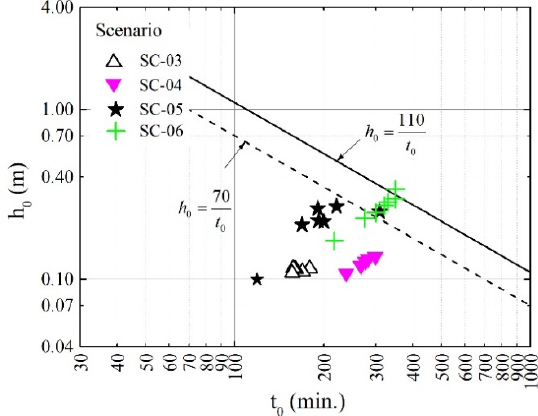
Figure 22. Comparison of levee damage level in different scenarios.